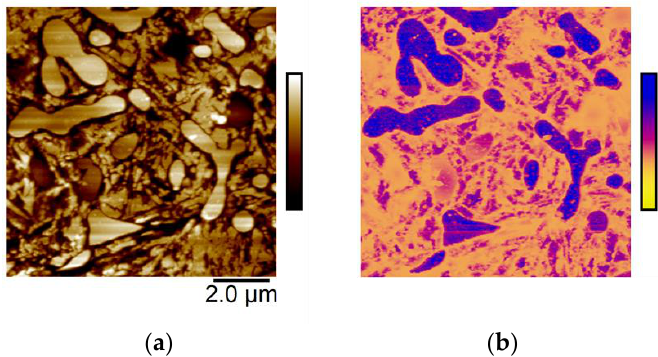
Figure 12. ( a ) CN topography (160 nm full scale), and ( b ) DMT Modulus (1.5 GPa full scale). Images are representative of 103–112 min submersion in 0.1M NaCl solution.